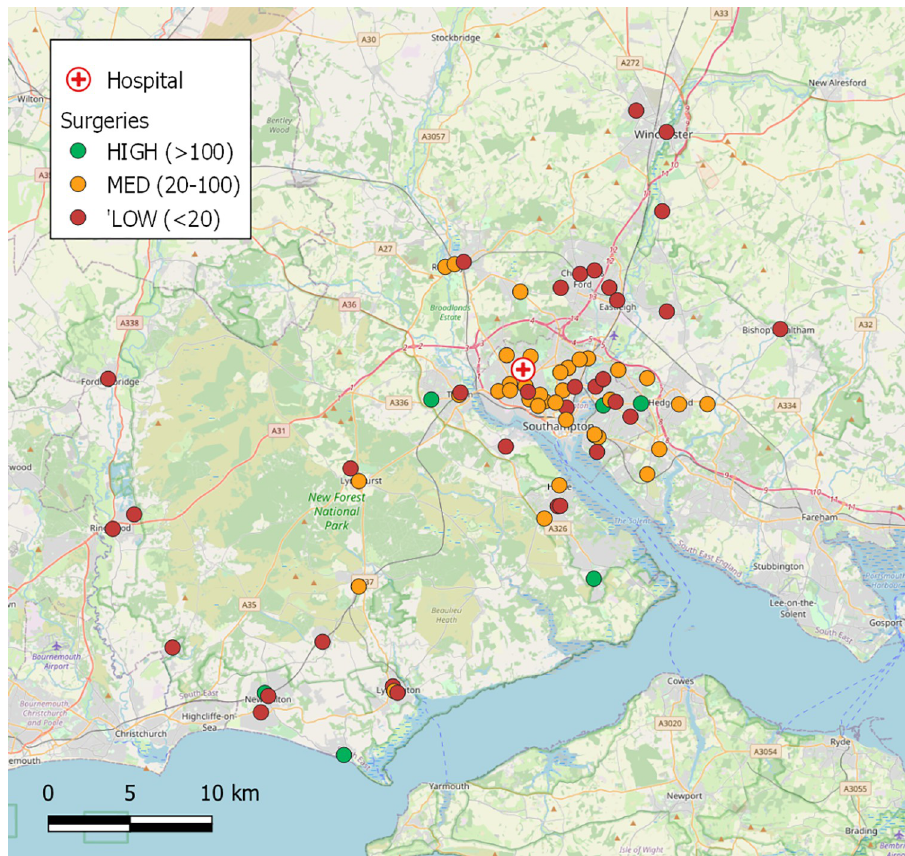
Fig 6. Surgery locations–coloured by daily sample production rate. Base map and data from OpenStreetMap and OpenStreetMap Foundation.